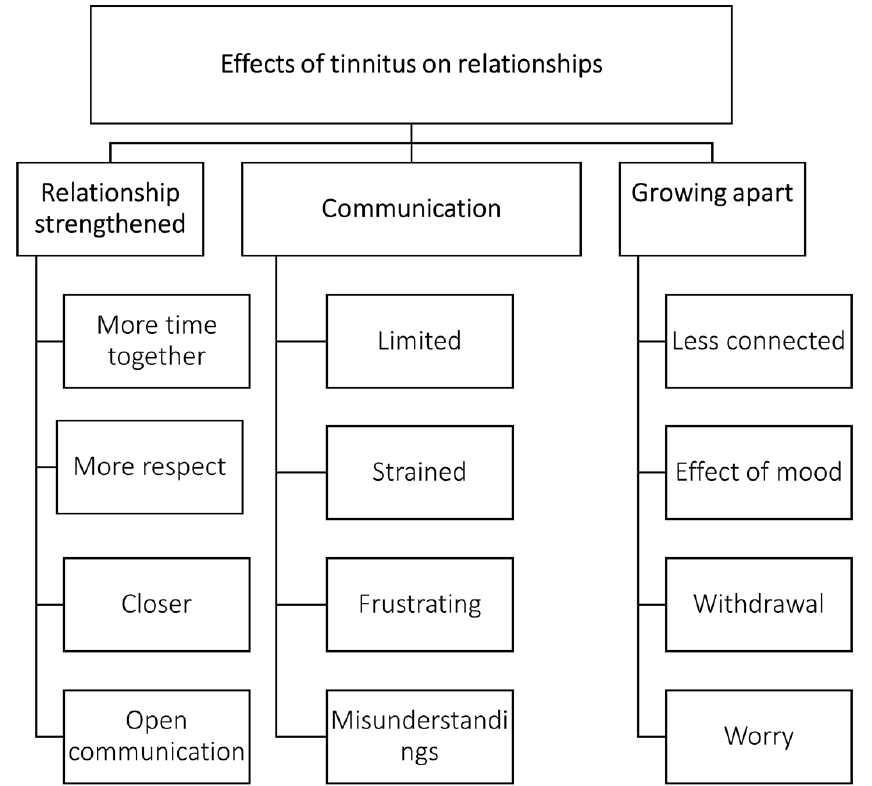
Figure 2. The effects of tinnitus on relationships.